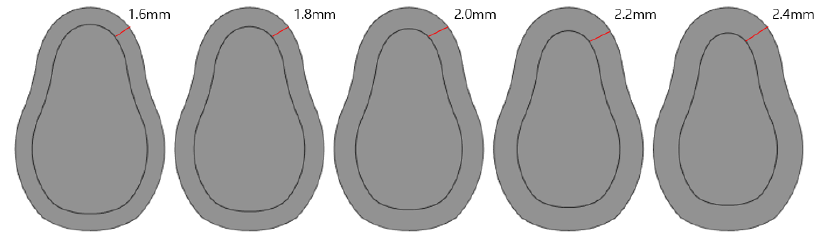
Figure 5. Cortical bone